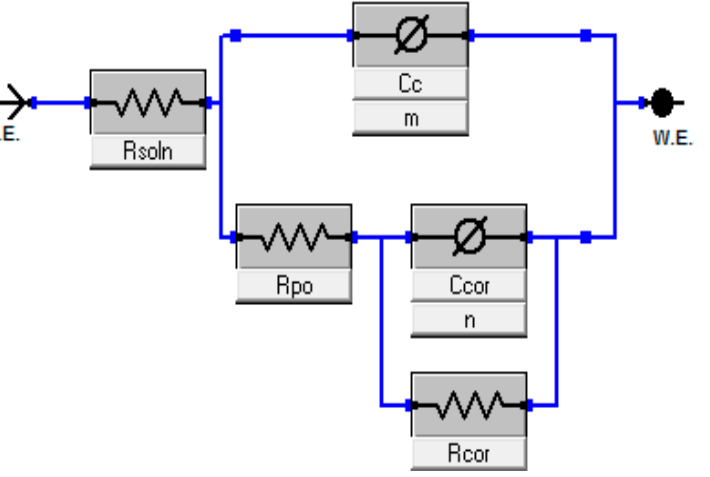
Figure 10. Equivalent circuit implemented for the electrochemical test with a reference electrode (Re), electrolyte resistance (Rsol) and resistance polarization resistance coating (Rp).